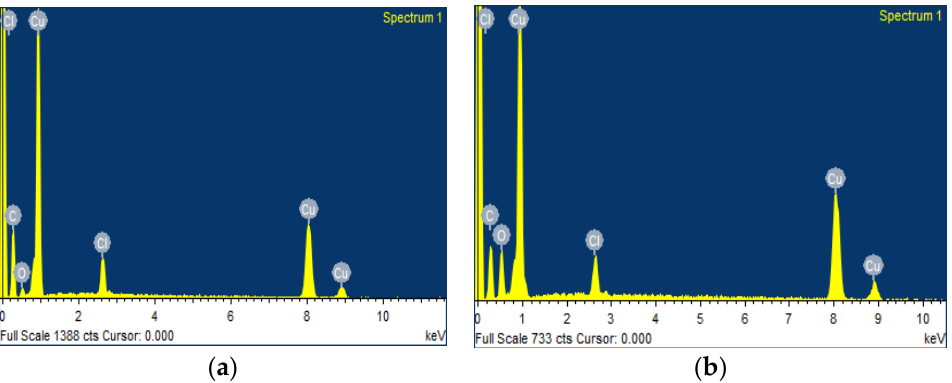
Figure 4. EDX spectra of copper and copper oxide-based electrodes: ( a ) copper-based electrode; ( b ) copper oxide electrode.